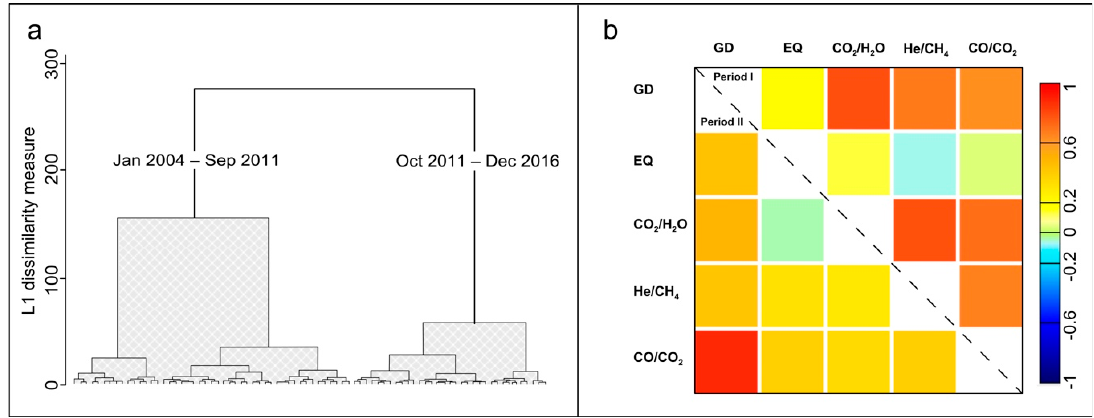
Figure 3. ( a ) Dendrogram of cluster analysis (Ward’s method); ( b ) Spearman’s correlations among